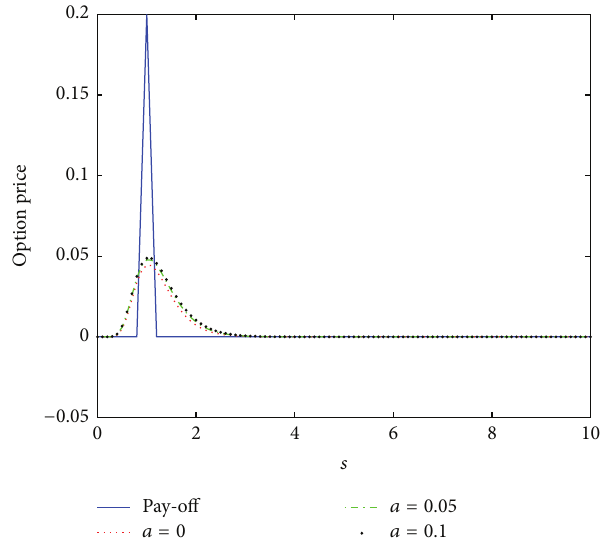
Figure 5: Option pricing of a European butterfly spread for several values of parameter 𝑎 at maturity time 𝑇 = 0.5 , where ℎ = 0.1 and Δ𝑡 = 0.005